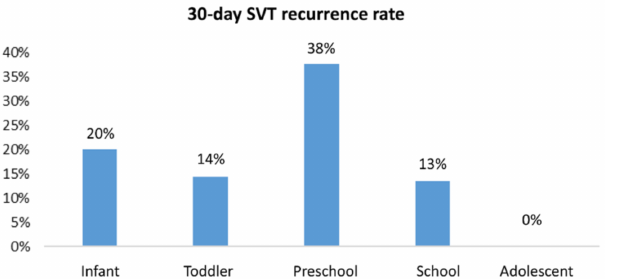
Figure 2. Distribution of 30-day SVT recurrence rate by age group. Infant: 28 d—<1 y; Toddler: 1—<3